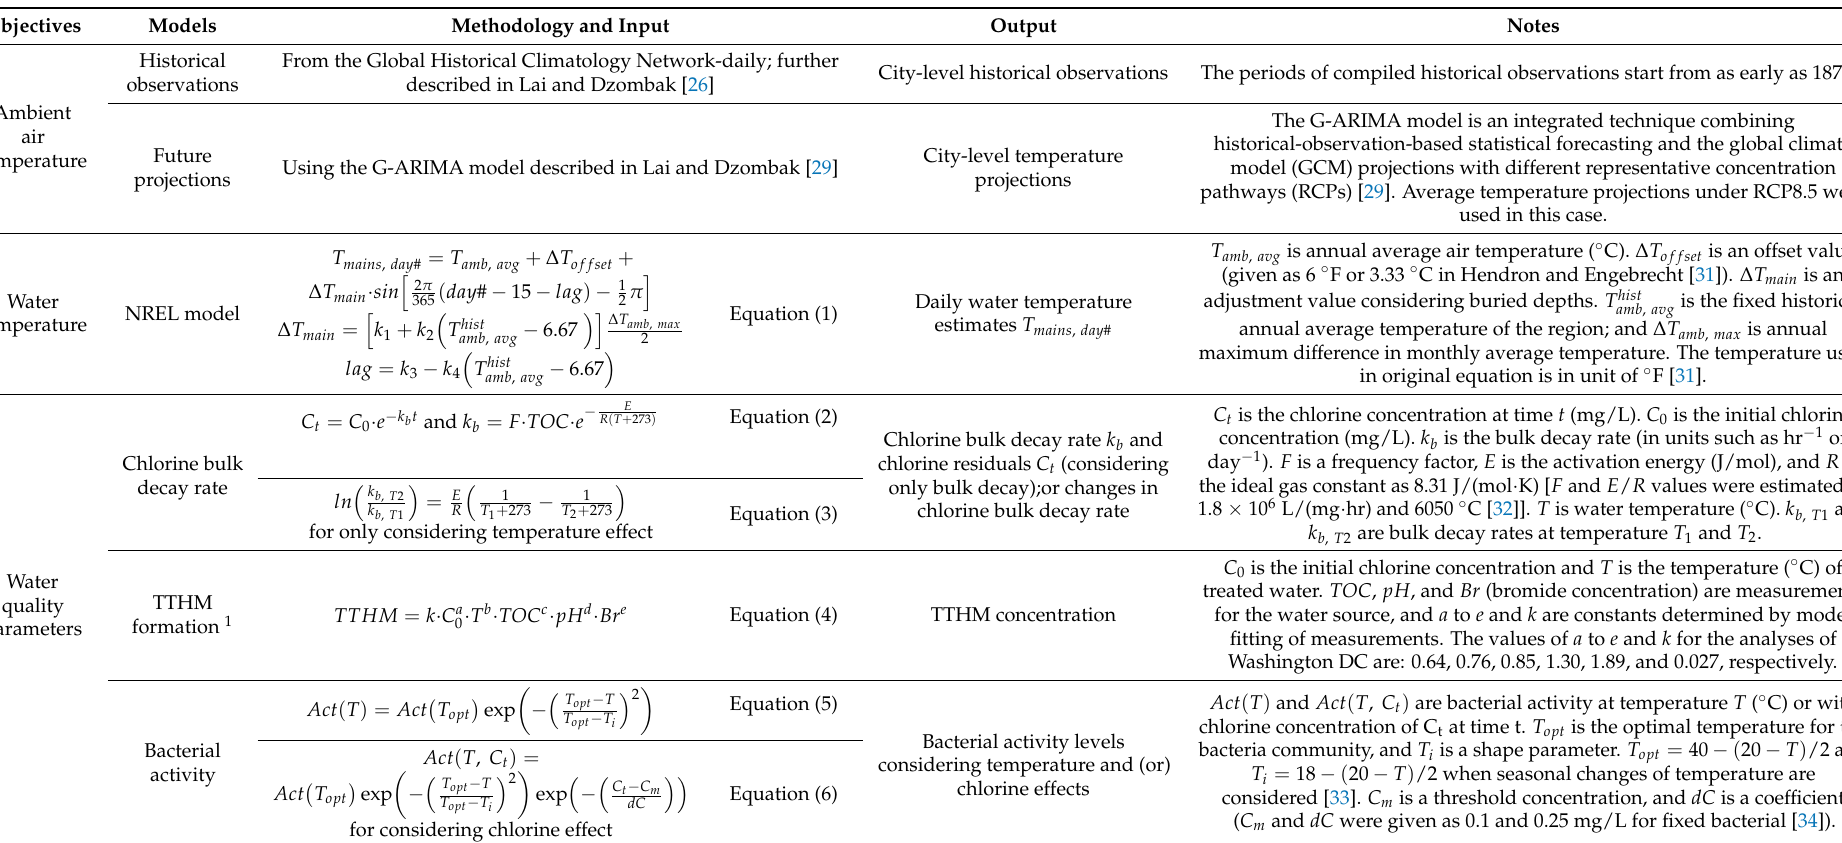
Table 1. Summary of the methods used for the individual components of the modeling processes in this